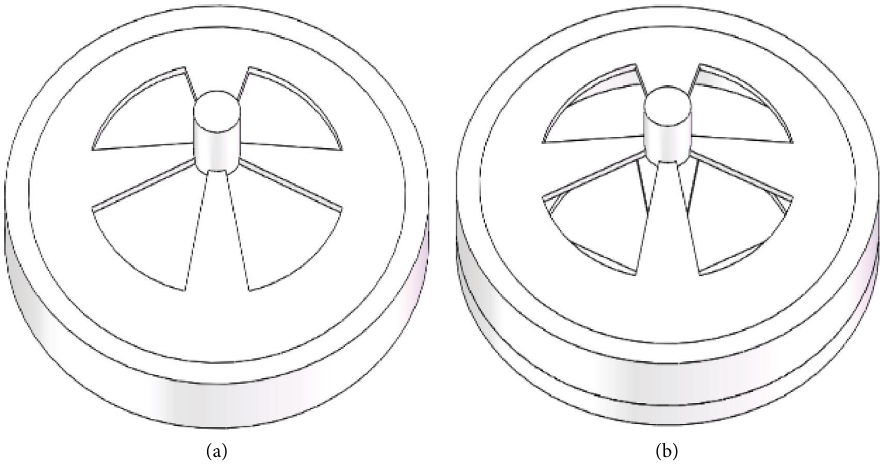
Figure 4: BQZSS: (a) single BQZSS and (b) two counter-pressure springs.